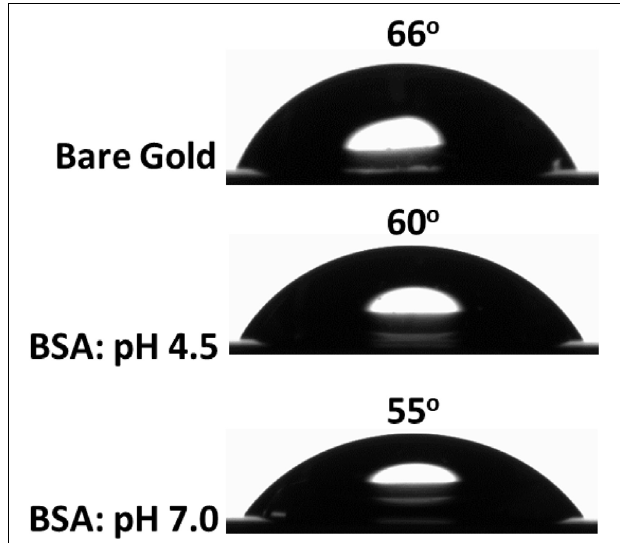
FIGURE 5 | Contact angle measurement of the bare gold interface (top) and the BSA layer adsorbed at the gold interface at pH 4.5 (middle) and at pH 7.0 (bottom)